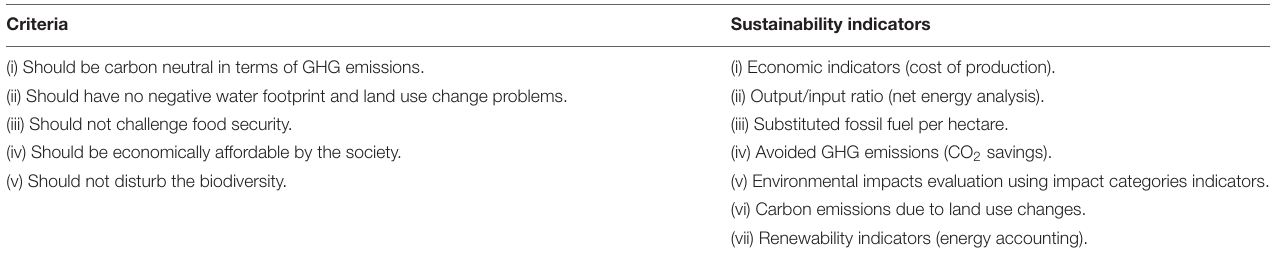
Criteria Sustainability